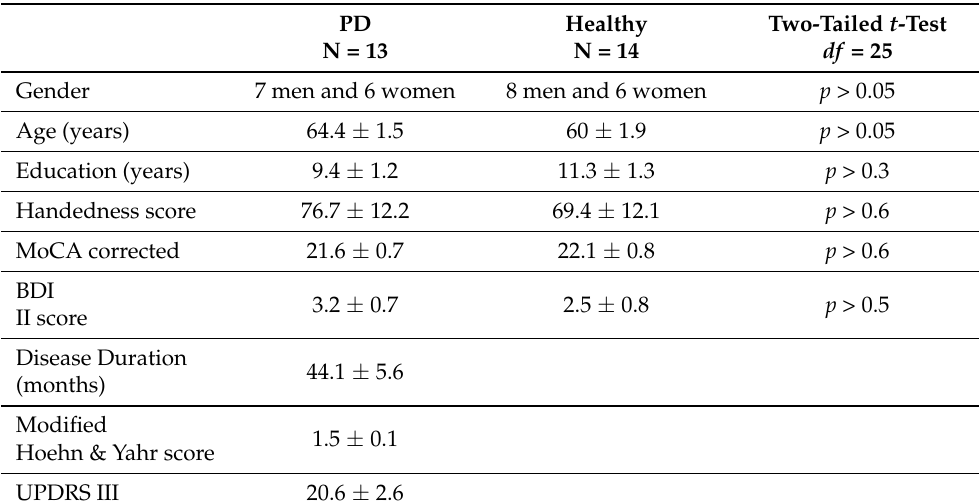
Table 1. Demographic characteristics and data about clinical evaluation of the subjects participating in the experiments. Features are reported in terms of mean ± SEM. PD Healthy Two-Tailed t -Test df = 25 N = 13 N = 14 7 men and 6 women 8 men and 6